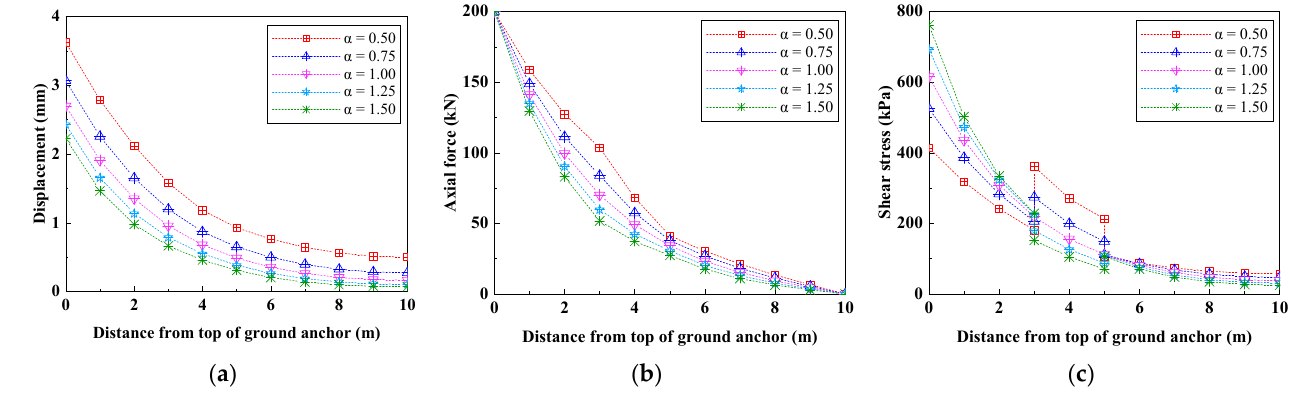
Figure 10. Effect of shear modulus change of Stratum-1 on mechanical behavior of ground anchor. (Case 2: condition 1) ( a ) displacement distribution curve; ( b ) axial force distribution curve; ( c ) shear stress distribution curve.